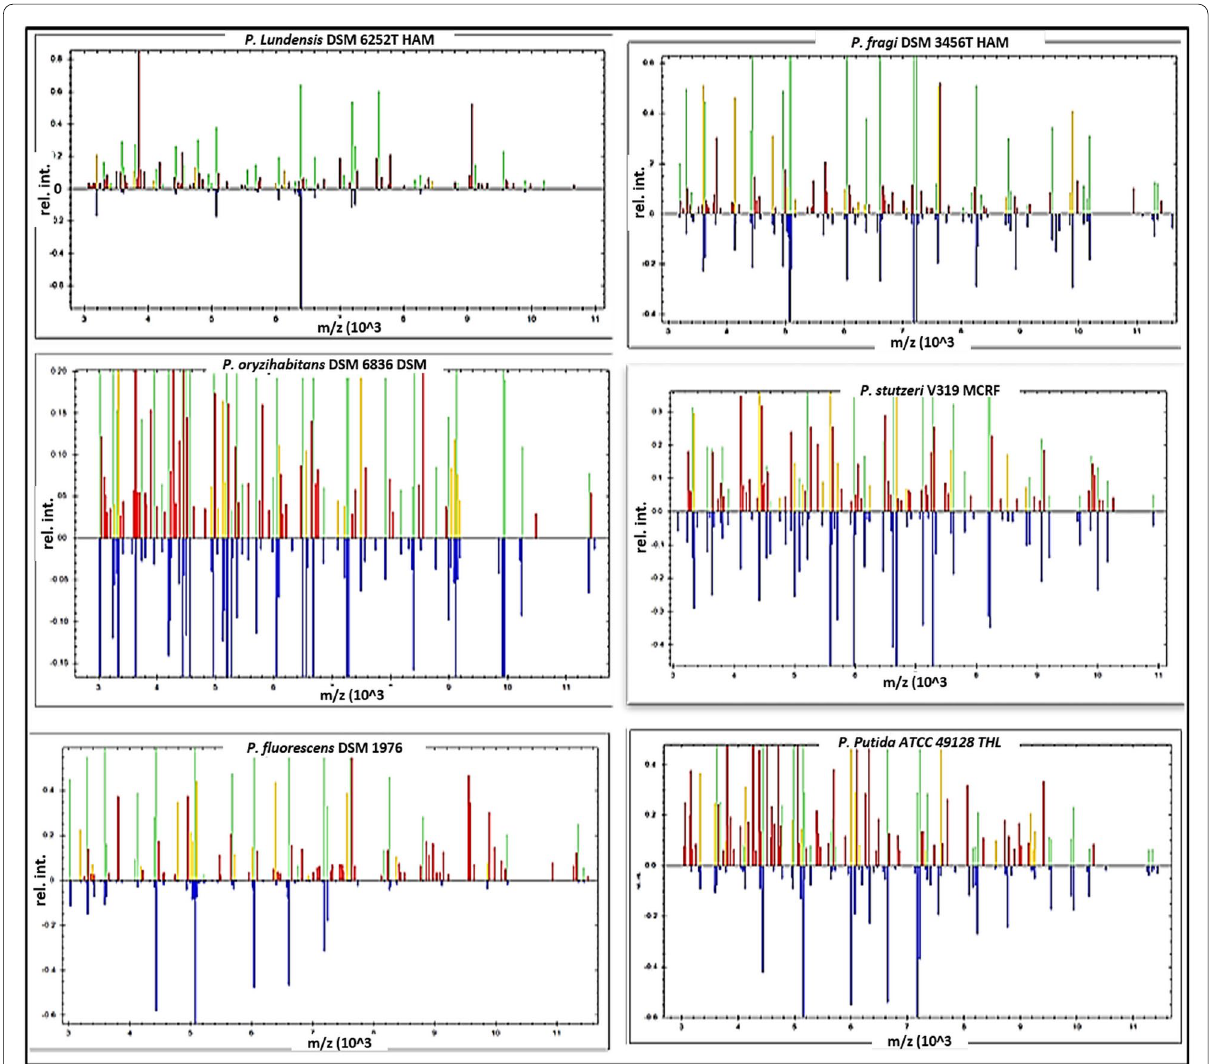
Fig. 3 Mass spectral protein profiles of different Pseudomonas species recovered from chicken meat samples compared with 6 reference strains deposited in the IVD Compass software of Microflex LT. The stored spectral proteins are represented by blue colour in the lower part, while the green spectra in the upper part indicate matched peaks, red spectra indicate incompatible peaks, and yellow spectra indicate intermediate peaks